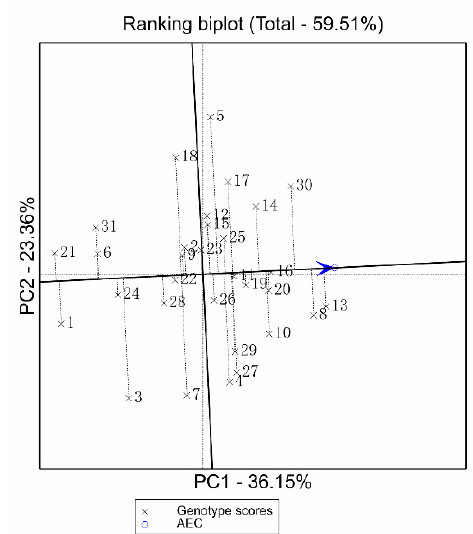
Figure 4. GGE biplot of high yield and stable maize inbred lines. Transform = 0, Scaling = 0, Centering = 2, and SVP = 1. The small circle represents the average environment and the straight line with an arrow is the average environment vector that points in the direction of greater performance. The vertical line drawn by the origin to the average environment vector represents the sensitivity of the participating inbred. From the point of the genotype to the average environment, the vector is perpendicular. The longer the perpendicular, the more sensitive the genotype. Conversely, the shorter the projection, the more stable the variety.